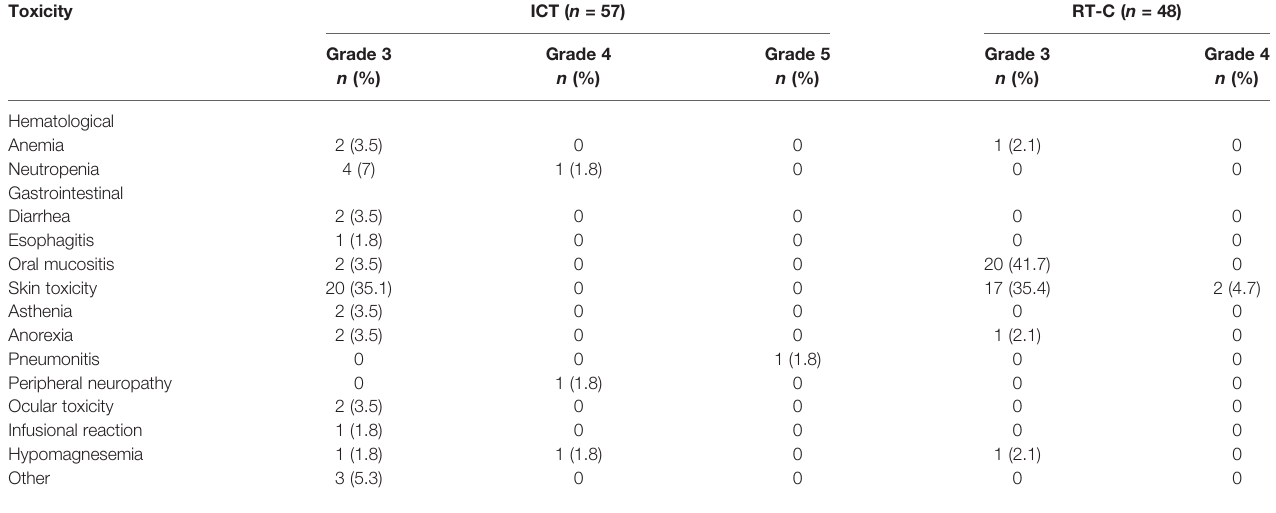
TABLE 3 | Relevant AEs (grade 3 – 5) to ICT and radical phase of